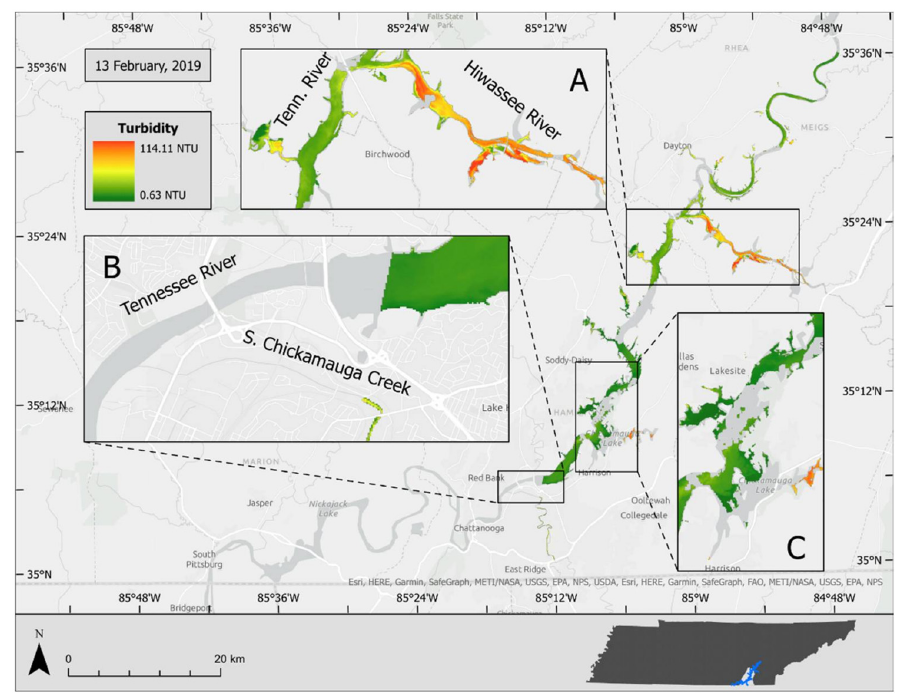
Figure 9. Turbidity estimated on 13 February 2019 by the turbidity estimation model. The insets highlight areas of high turbidity variability due to the convergence of lakes and streams. Site A details the confluence of the Tennessee and Hiwassee Rivers, Site B highlights the increased turbidity of South Chickamauga Creek, and Site C details the Harrison Bay